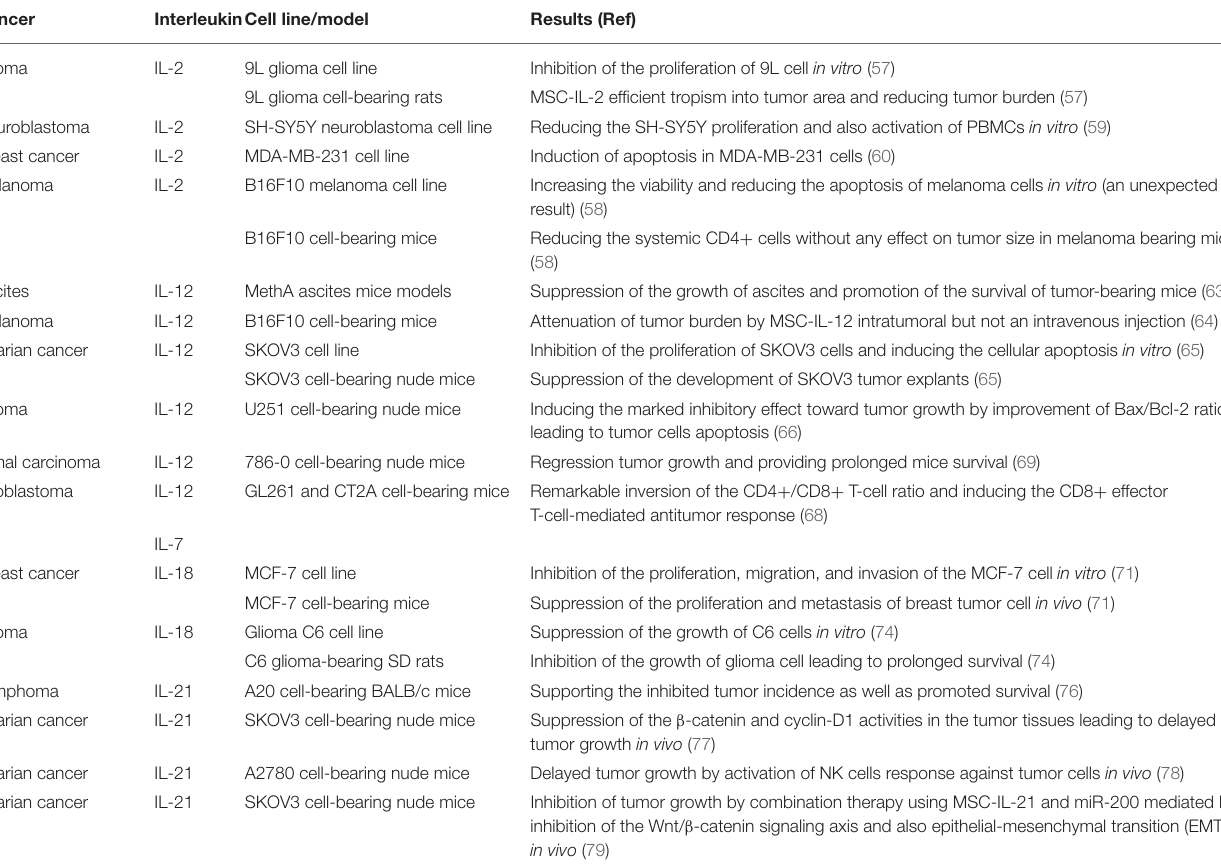
TABLE 2 | The overview of studies based on the use of mesenchymal stem/stromal cells (MSCs) as a carrier for delivery of interleukins to treat human tumors ( in vitro and in vivo ).